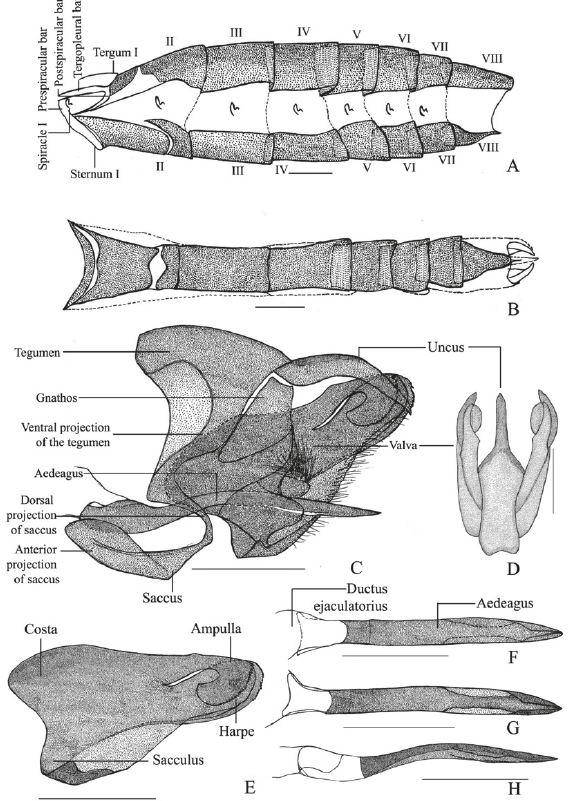
Figure 5. Male genitalia of Junonia iphita (Cramer, 1779) A – B - abdomen (dorsal and ventral view, respectively); C - male genitalia (lateral view); D - uncus (dorsal view); E - right valva (inner view); F – H - aedeagus (dorsal, ventral and lateral view respectively). Scale bar 1mm.